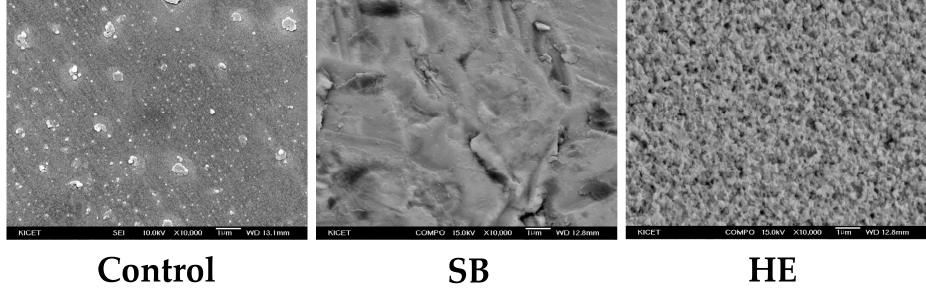
Figure 4. Scanning electron microscopy images of treated zirconia surfaces (Original magnification ×10,000). SB, sandblasted; HE, hot-etched. × 10,000). SB, sandblasted; HE, hot-etched.